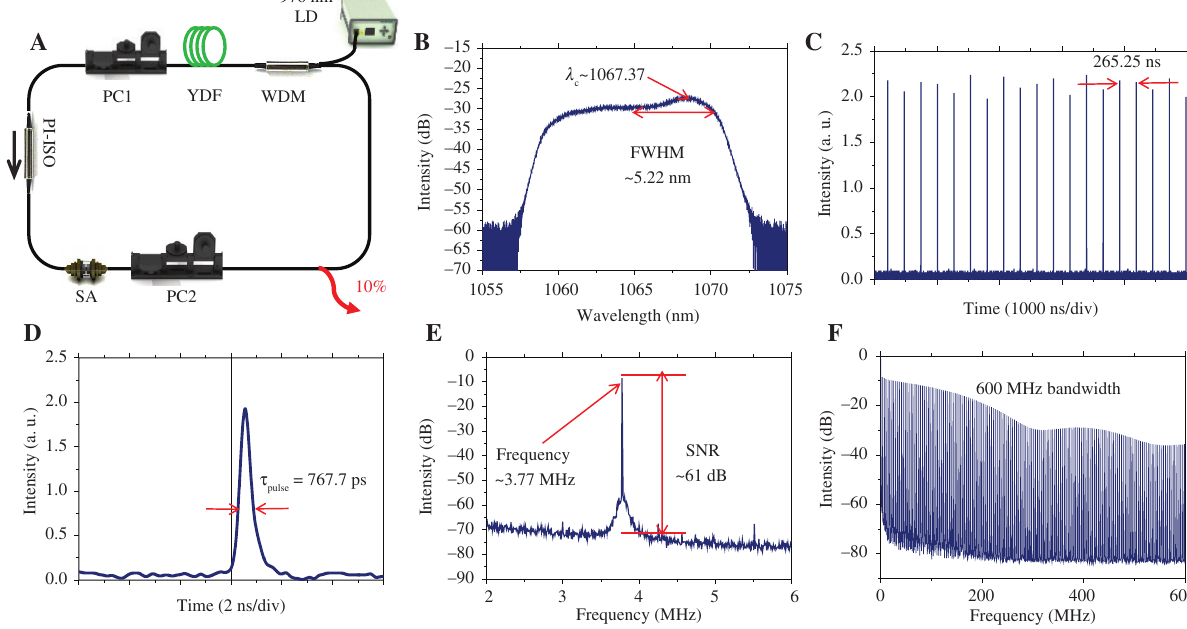
-based mode-locked Yb-doped fiber laser. 2